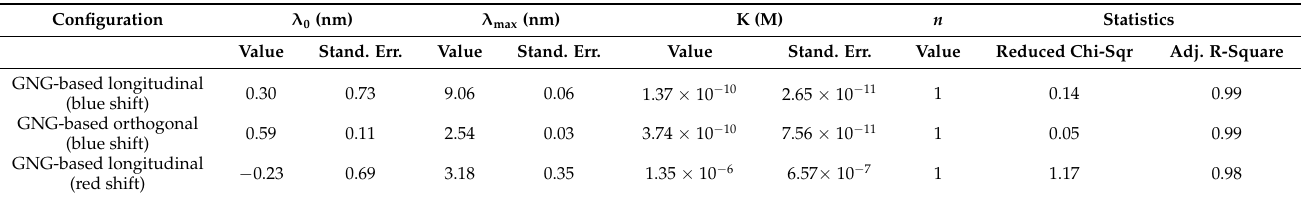
Table 1. Hill fitting parameters relative to Equation (1) for different sensor configurations.